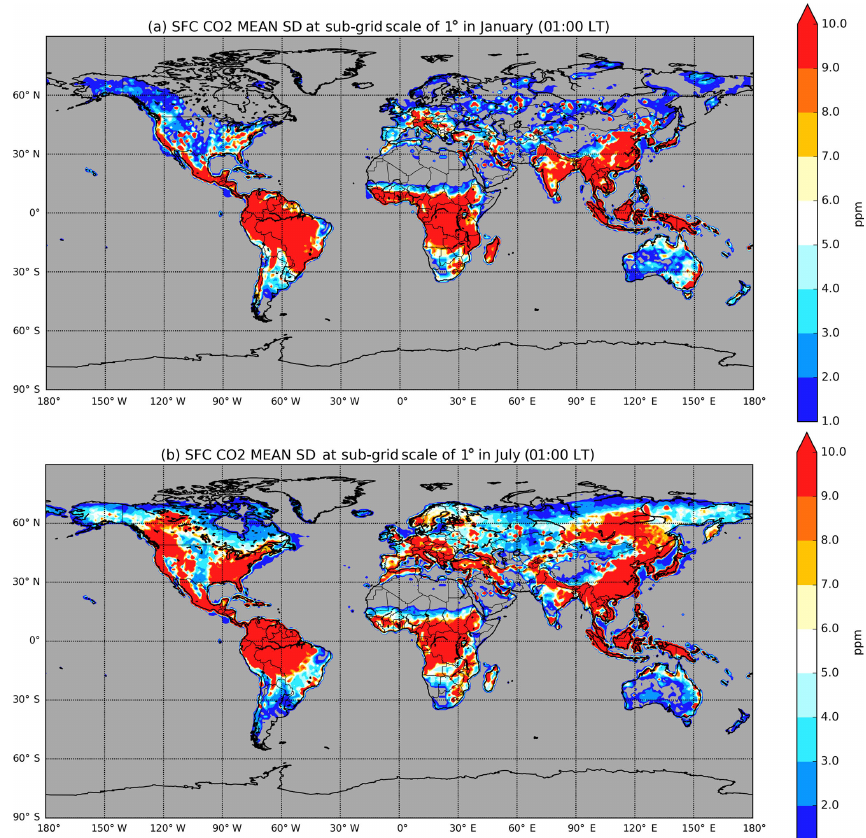
Figure 12. Monthly mean surface CO 2 small-scale variability ( σ ) within 1 ◦ × 1 ◦ grid boxes (ppm) at 01:00 local time in (a) January and (b) July. Grey shading denotes σ < 1 .